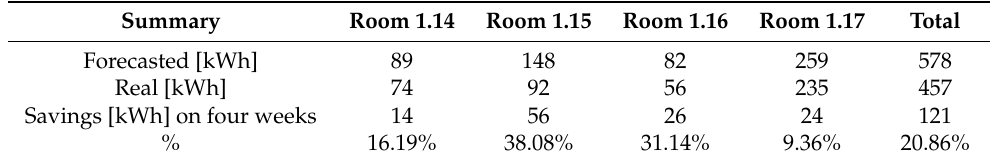
Table 2. Energy savings for heating in campaign.